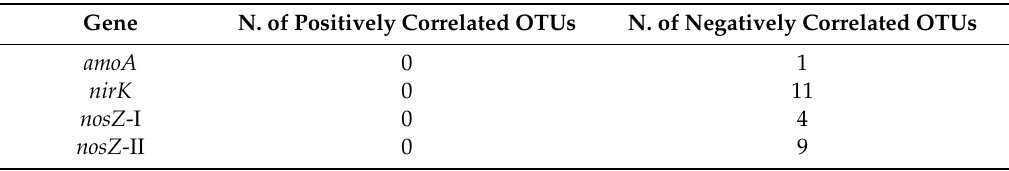
Table 5. Significant Spearman correlations (at FDR-corrected p < 0.05) between relative abundances of bacterial Operational taxonomic units (OTUs) and qPCR values of the N-cycle genes a ff ected by fertilization treatments (see Figure 3), in the bulk